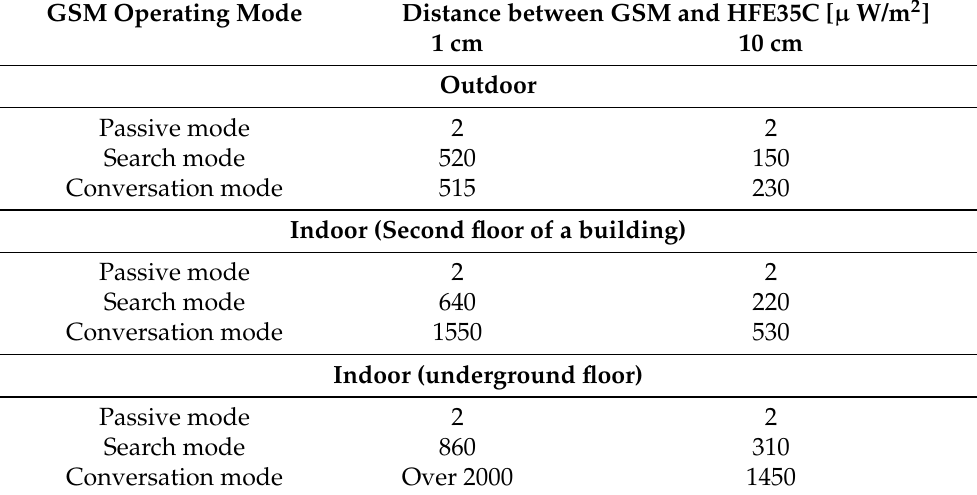
Table 2. EMF values generated by a GSM